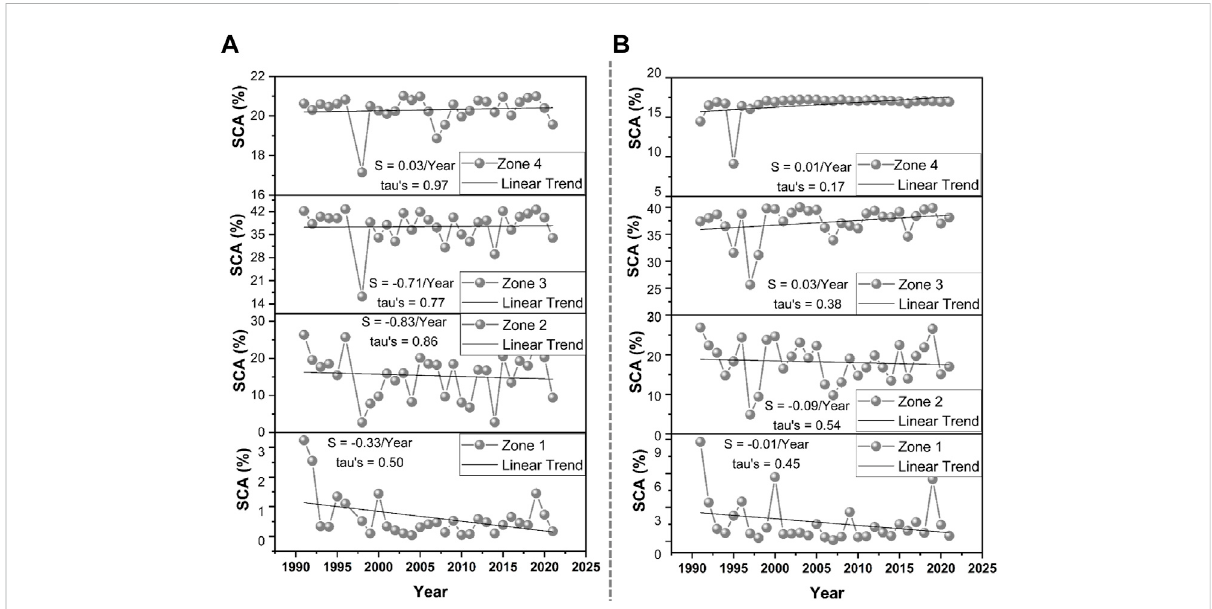
FIGURE 6 Mann – Kendall trend of annual SCA derived from Landsat data in four elevation zones of (A) Astore and (B) Shigar over a 31-year period (1991 – 2021). Kendall tau, “ tau ’ s ” ; Sen ’ s slope, “ S.